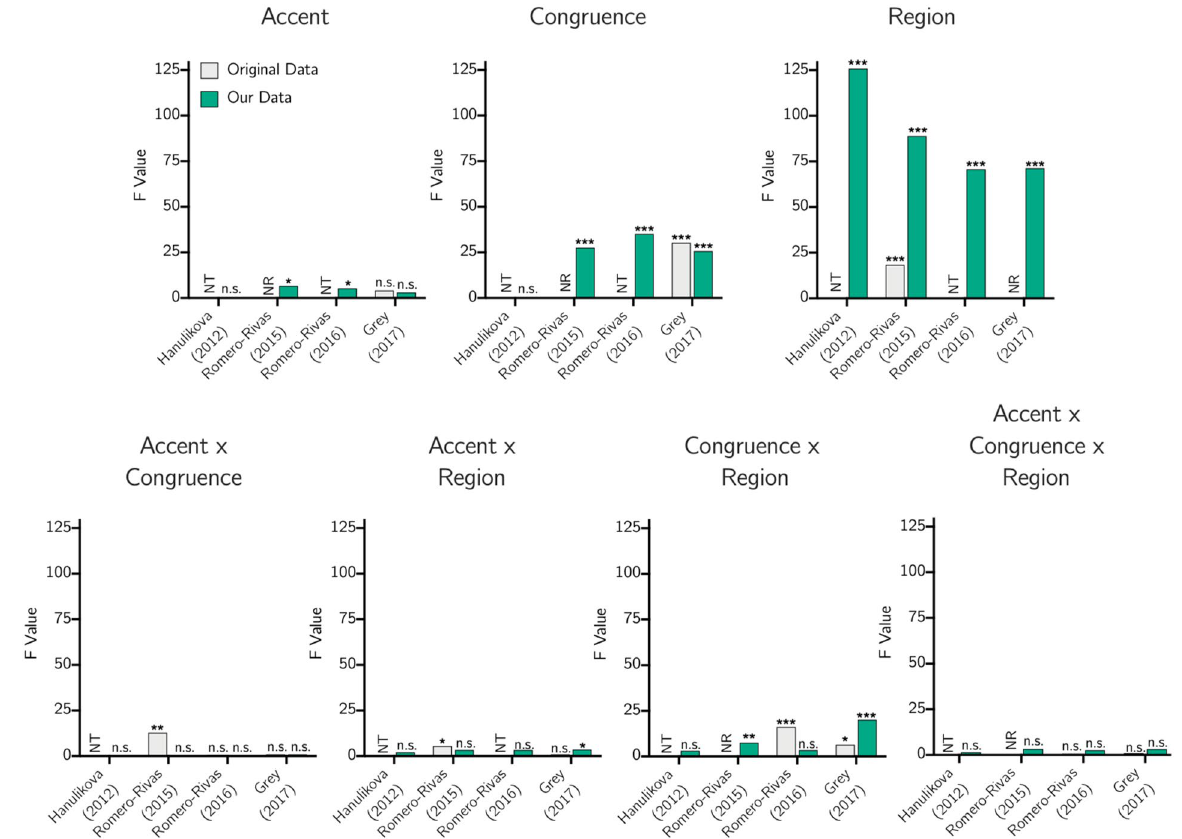
Figure 4. A graphical representation of F values for each main effect and interaction in the P600 time range found using each parameter set, either as reported in the original study (“original data”) or using our data (“our data”). Note: Stars indicate significance (* p < 0.05, ** p < 0.01, *** p < 0.001), “n.s.” indicates not significant at p < 0.05, “NR” indicates the main effect or interaction was tested in the original study but a significant result